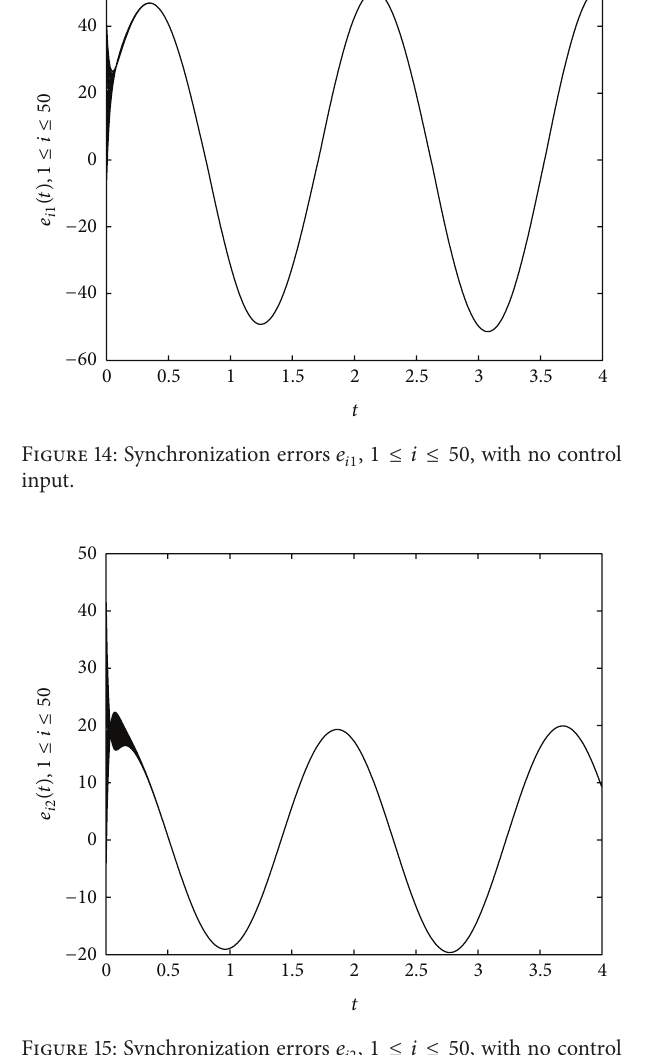
Figure 15: Synchronization errors 𝑒 𝑖 2 , 1 ≤ 𝑖 ≤ 50, with no control input.